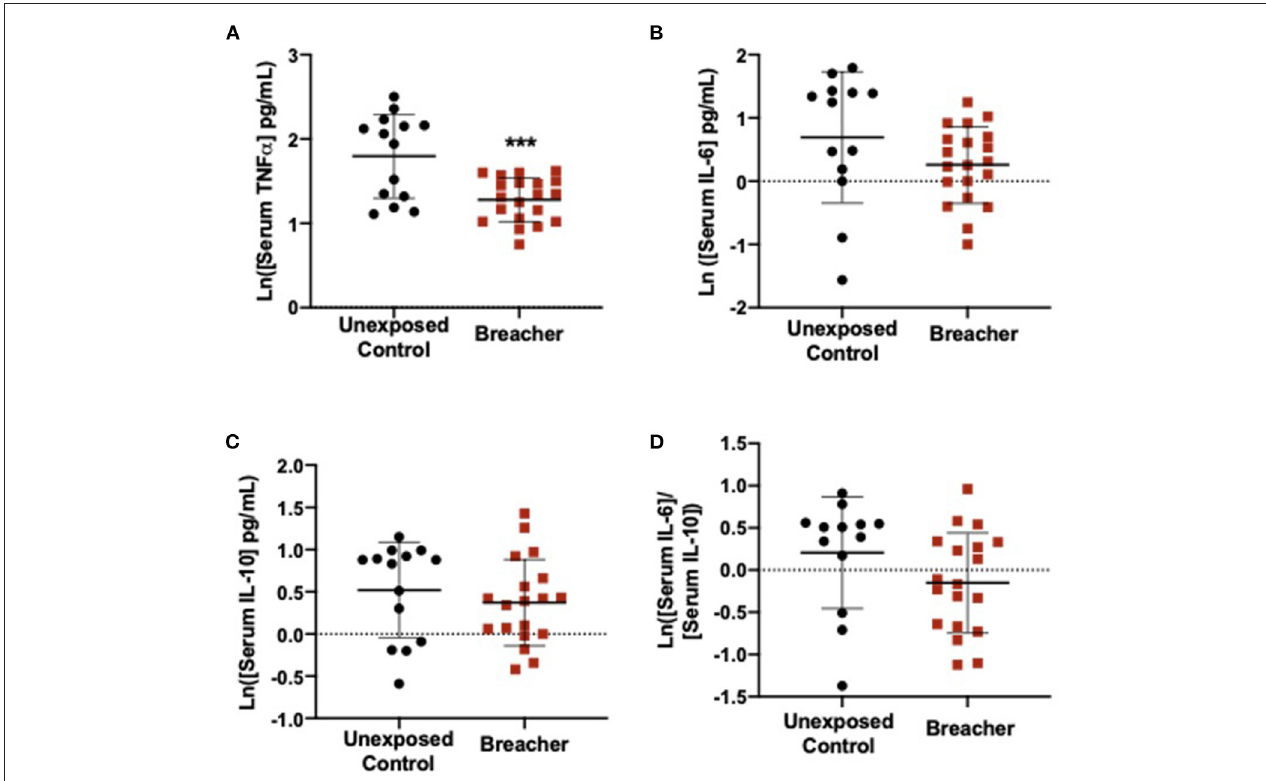
FIGURE 1 | Serum levels of pro-inflammatory cytokine TNF α decreased in breachers. (A) Serum TNF α is decreased in breachers as compared to unexposed controls, (B) No change in serum IL-6 in breachers as compared to unexposed controls, (C) No change in serum IL-10 between groups, (D) No change in the IL-6/IL-10 ratio between groups. Significant p -values are represented as: *** p <